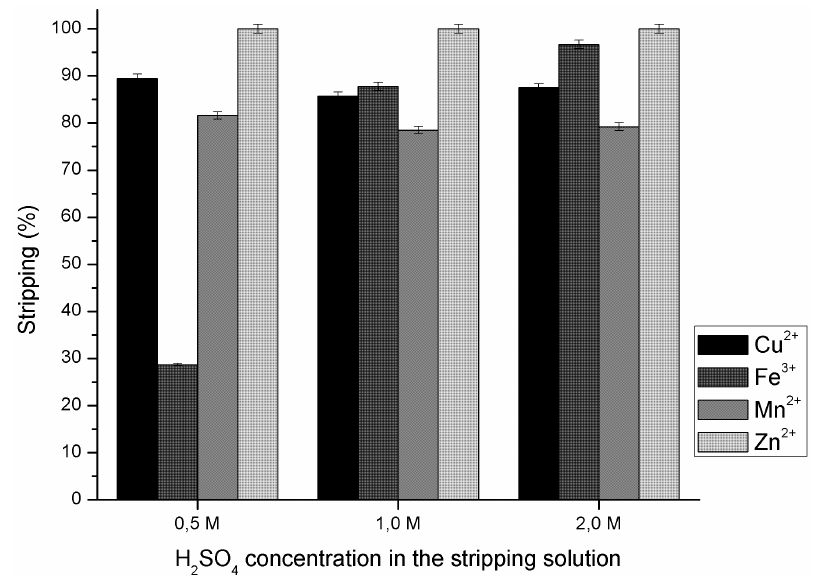
Figure 3. Effect of sulfuric acid on the stripping percentage of metals from loaded organic phase. Experimental conditions: R 4 NCy = 0.54 M, O/A = 1, 400 min − 1 , and 20 min of stirring time.